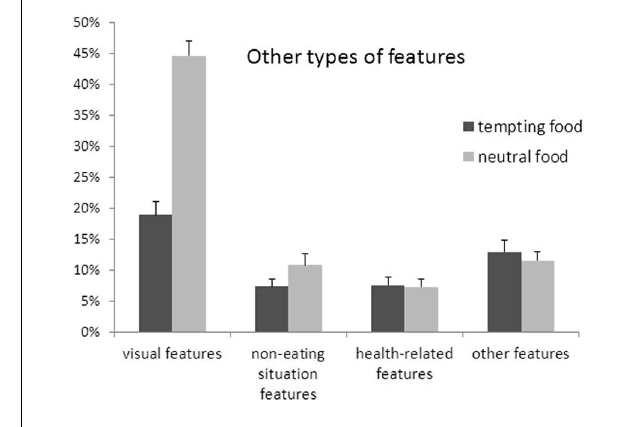
FIGURE 1 | Percentages of eating simulation features and other types of features for tempting and neutral food. Eating simulation features are all features in the categories taste, texture, temperature; hedonic; eating situations. Other types of features are all features in the categories visual;